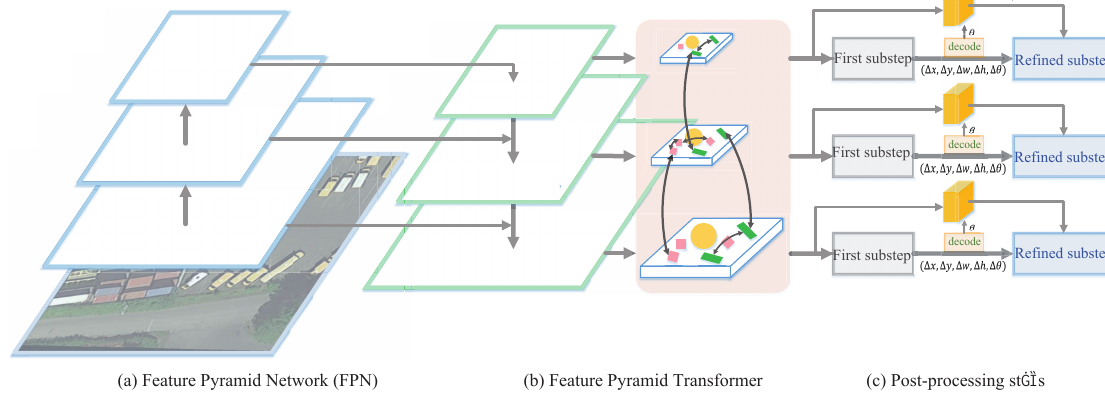
Figure 3. The framework of the proposed ADT-Det detector. Our pipeline consists of a backbone network and two post-processing steps. An FPN network is used as backbone network and a feature pyramid transformer is proposed to enhance the feature extraction. Then, the backbone is attached in the post-processing steps, which consist of two sub-steps: first, a sub-step and a refinement step. In the first sub-step, the preliminary regression of locations and angles for the refinement sub-step is performed. In the refinement sub-step, adaptive feature refinement is performed first and then the final object detection result is given